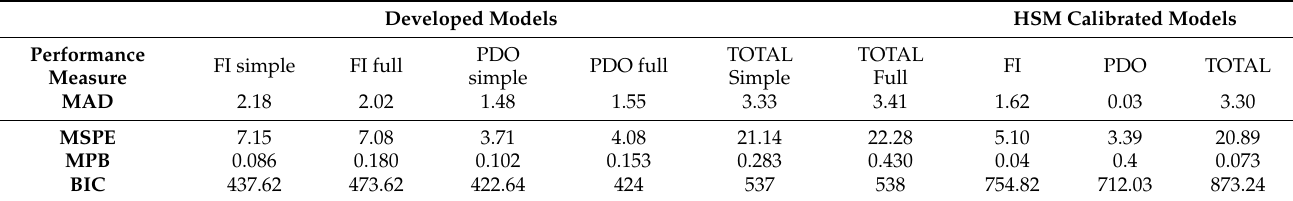
Table 4. Goodness of fit measures for the HSM calibrated and developed